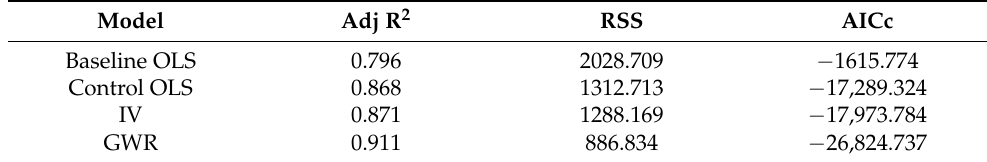
Table 3. Model Performance Comparison.